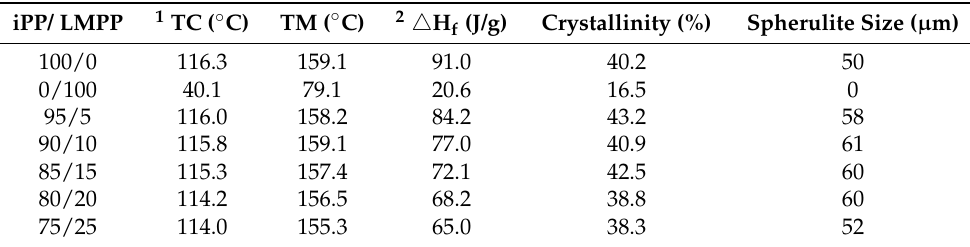
Figure 8. Intracycle strain thickening (T; ( a )), intracycle strain stiffening (S; ( b )) and Q parameter ( c ) as a function of strain-rate amplitude 𝛾̇ 0 and strain amplitude γ 0 under LAOS stress for pure iPP, LMPP and blends at 1.0 rad s −1